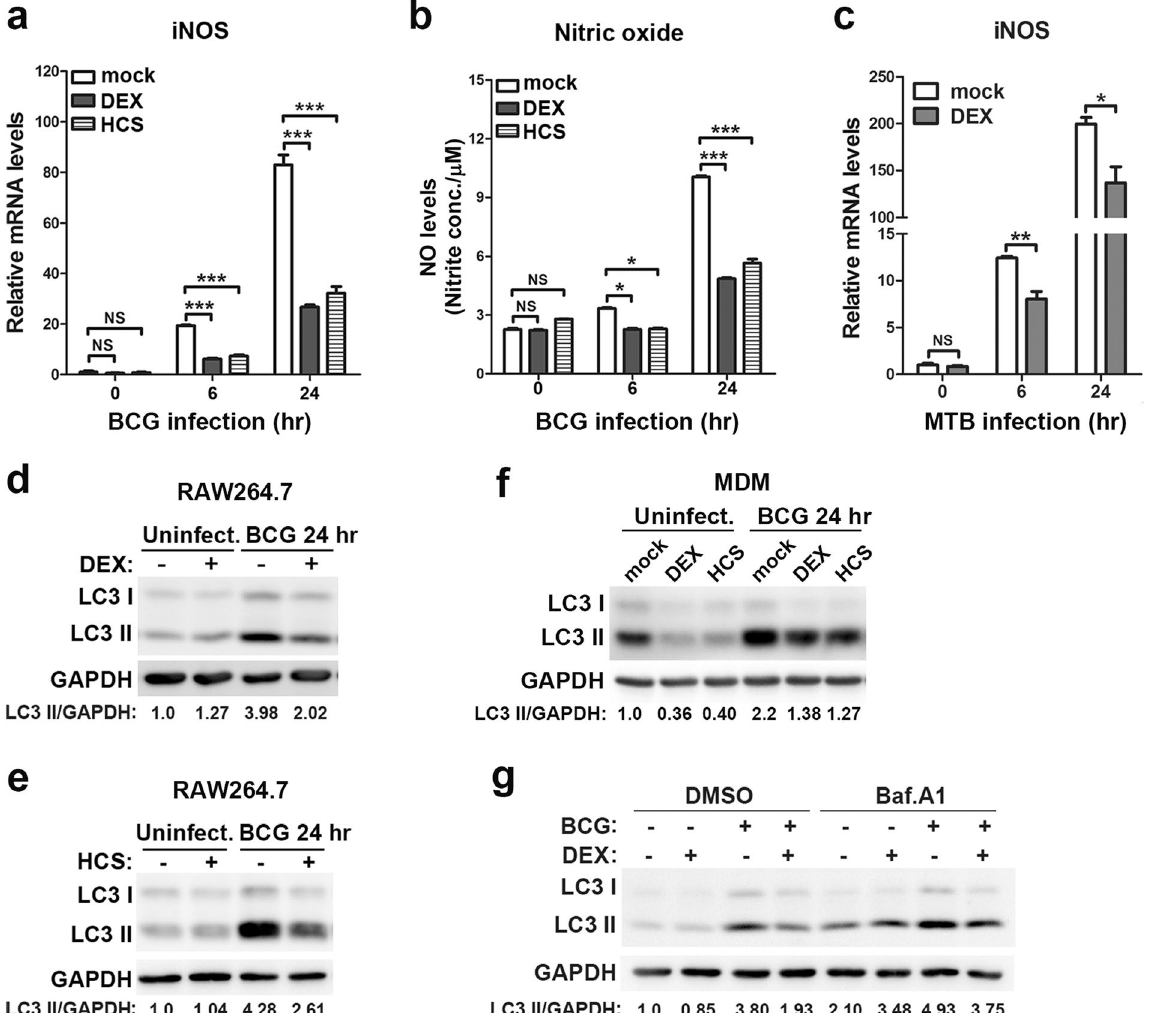
Figure 1. Glucocorticoids suppress iNOS/NO and autophagy in mycobacteria-challenged macrophages. ( a , b ) RAW264.7 cells were pretreated with dexamethasone (DEX) (1 μ M), hydrocortisone (HCS) (1 μ M) or vehicle control ethanol (mock) for 6 hr and were then challenged with M. bovis BCG (MOI 5) for the indicated time. iNOS mRNA level was assessed with real-time PCR ( a ). NO in the supernatant was detected with the Griess assay ( b ). ( c ) RAW264.7 cells were pretreated with DEX (1 μ M) or vehicle control ethanol (mock) for 6 hr and then challenged with M. tuberculosis H37Rv (MOI 5) for the indicated time. iNOS mRNA level was assessed with real-time PCR. ( d , e ) RAW264.7 cells were pretreated with DEX (1 μ M) ( d ), HCS (1 μ M) ( e ) or vehicle control ethanol (mock) for 6 hr and then challenged with M. bovis BCG (MOI 5) for 24 hr. The LC3 level was detected with Western blot analysis. Full-length blots are presented in Supplementary Figs 4 and 5, respectively. ( f ) MDMs were pretreated with DEX (1 μ M), HCS (1 μ M) or vehicle control ethanol (mock) for 6 hr and then challenged with M. bovis BCG (MOI 5) for 24 hr. The LC3 level was detected with Western blot analysis. Full-length blots are presented in Supplementary Fig. 6. ( g ) RAW264.7 cells were treated as described in ( d ), and cells were treated with Bafilomycin A1 (Baf. A1, 100 nM) 2 hr before cellular protein extraction for Western blot analysis. The LC3 level was detected with Western blot analysis. Full-length blots are presented in Supplementary Fig. 7. Relative band intensity of LC3 II was calculated after normalization by load control GAPDH and is shown below each lane. For Western blot analysis, GAPDH was used as the loading control, and data are representative of three independent experiments with similar results. For real-time PCR, the level of each mRNA was normalized to that of β -actin mRNA and is expressed relative to expression in unstimulated cells. Data are shown as the mean ± SEM of three independent experiments. * p < 0.05; ** p < 0.01; *** p < 0.001. NS, not